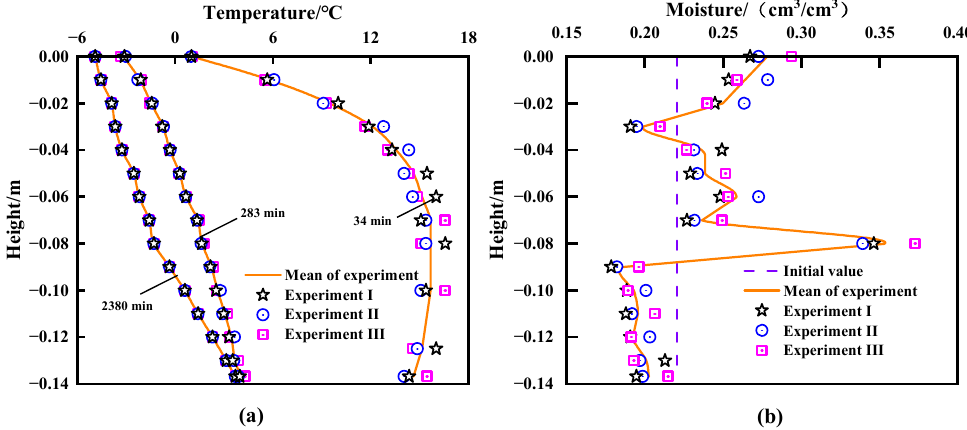
Figure 2. Experimental results. ( a ) Temperature field at the typical time; ( b ) the moisture field at the end of the experiment.